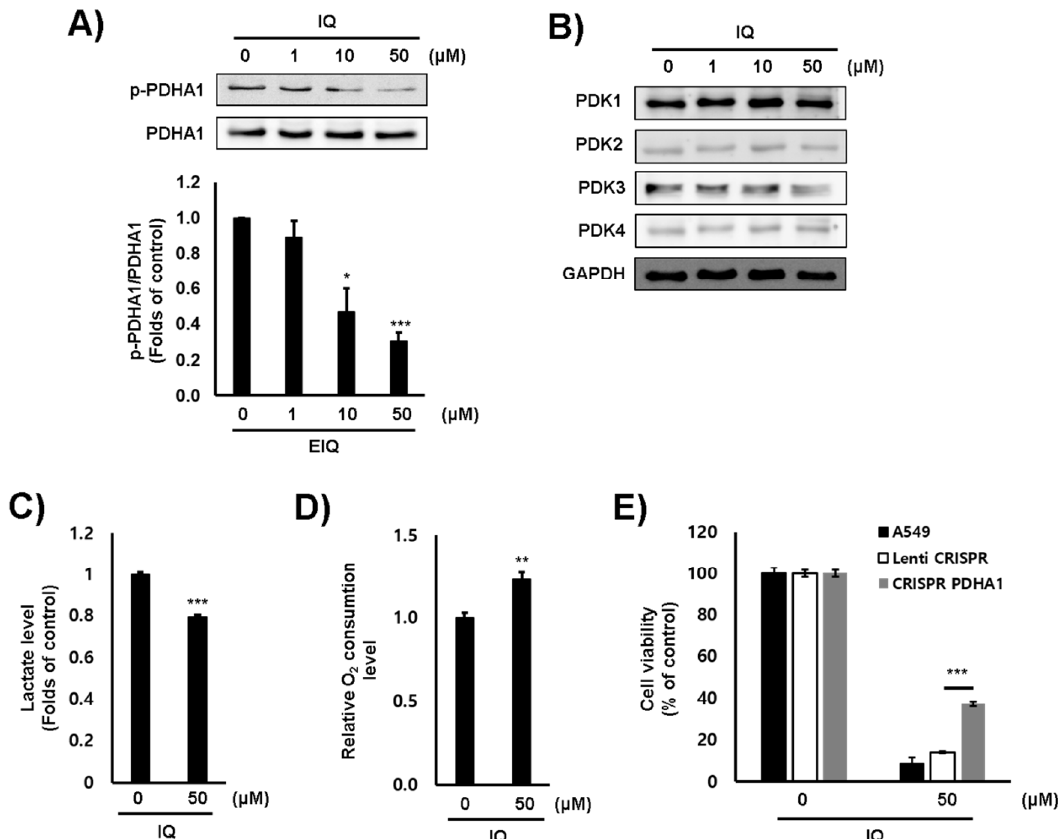
Figure 2. IQ reduced PDK activity and promoted OxPhos in A549 cells. The A549 cells were treated with IQ for 4 h. ( A , B ) The levels of phosphorylated PDHA1 ( A ) and PDK1–4 ( B ) were analyzed via Western blotting. (( A ), lower panel ) The bar graph from three independent experiments (( A ), upper panel ) is shown; PDHA and GAPDH were used as loading controls. ( C ) Lactate production after IQ treatment was measured using a lactate fluorometric assay kit. ( D ) The cells were treated with IQ, and the O 2 consumption rate was measured using a commercially available Oxygen Consumption Rate Assay Kit. ( E ) The cells were treated with the indicated concentrations of IQ for 24 h. The viability of these cells was measured using the MTT assay. All experiments except for panel B were performed at least three times, and data are shown as the mean ± SD. Statistical analyses were performed using Student’s t -test. *, p < 0.01 **, p < 0.05 and ***, p < 0.001 compared with the control.